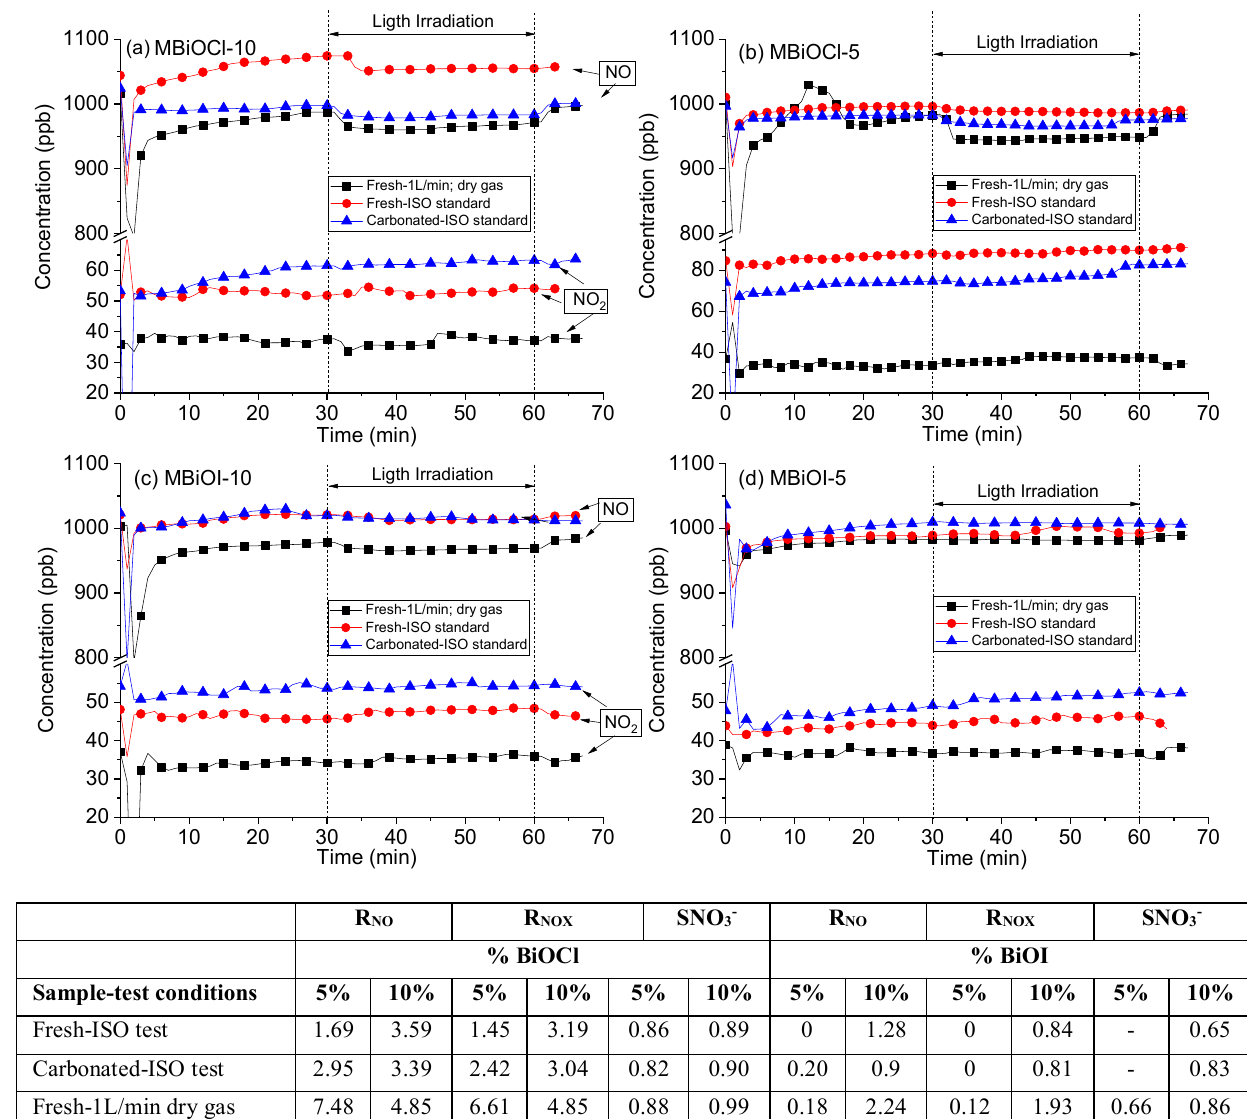
Figure 12. NO and NO 2 concentration profiles during the photocatalytic tests for BiOCl and BiOI with 5 and 10% of photocatalyst. The percentages of removed NO (R NO ) and NO x (R NOx ), and selectivity to nitrates, S NO3−, are given below.